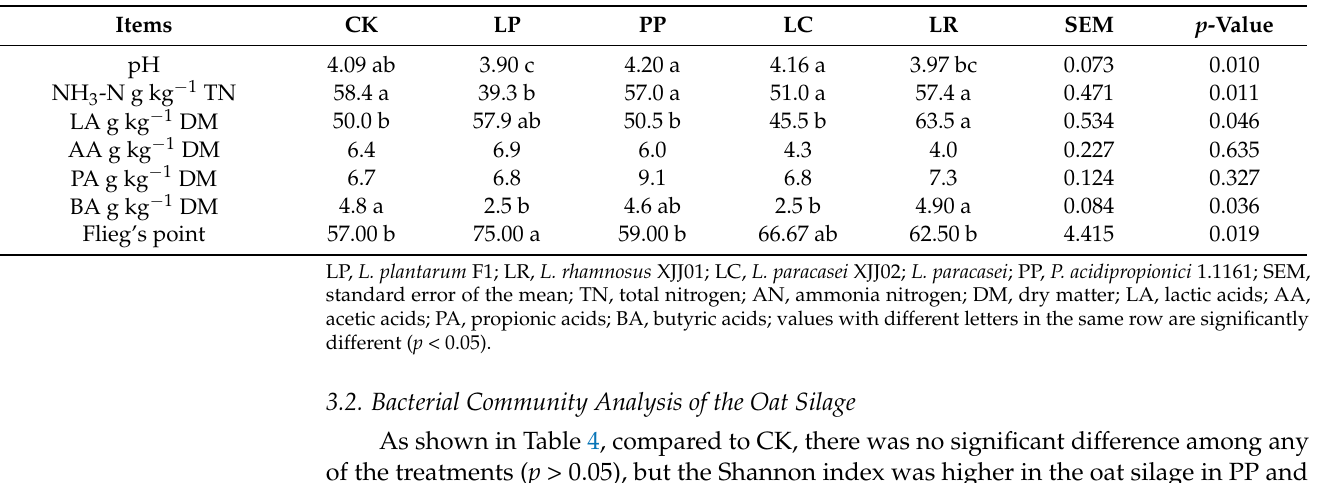
Table 3. Fermentation quality of the oat silage.